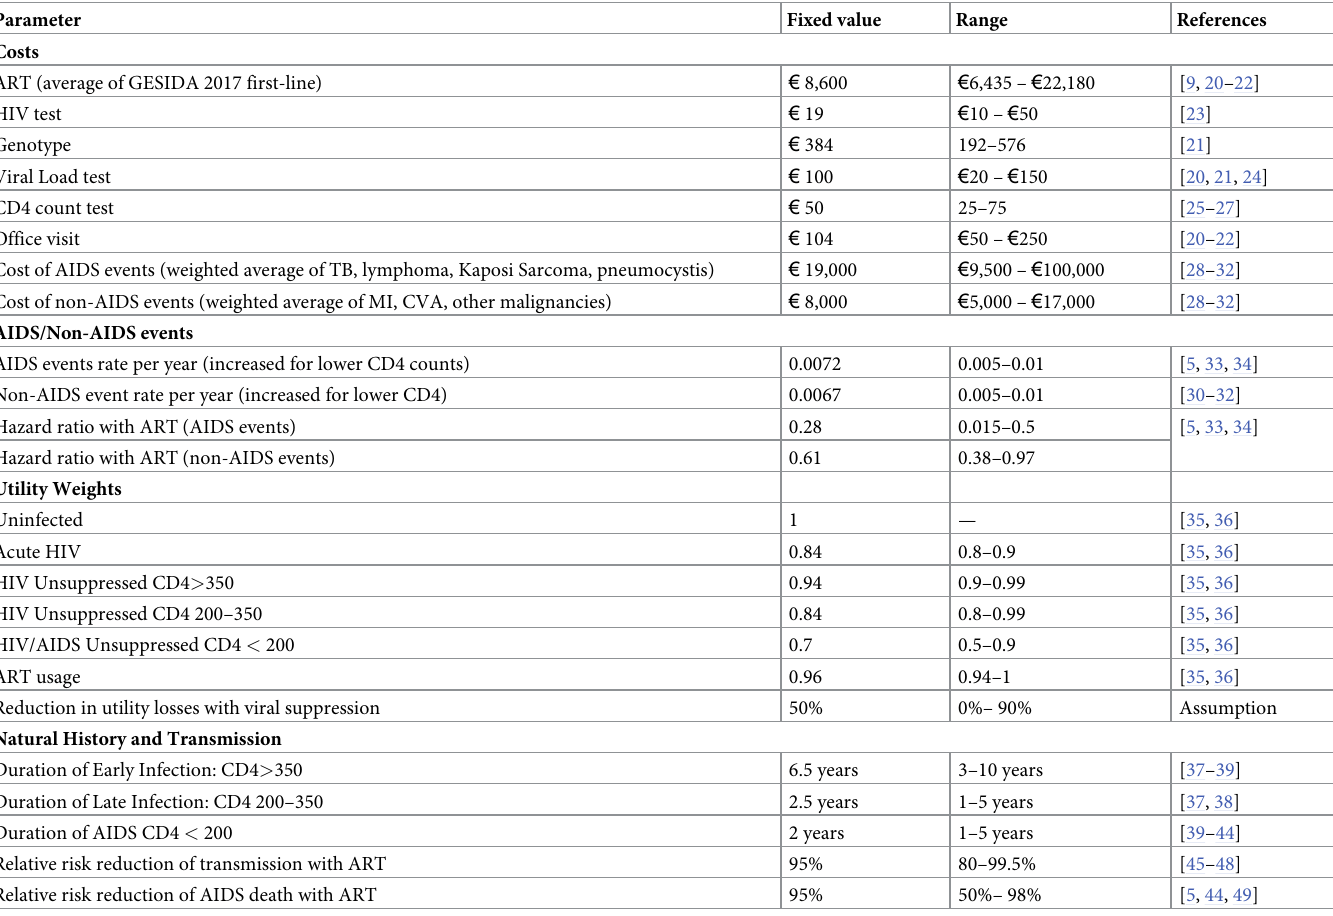
Table 1. Key model input parameters. Event rates and ART effects were based on START Trial; we used literature estimates from Spain for costs of various AIDS and non-AIDS events, and utilized a weighted average based on specific event rates in START trial. Parameter Fixed value